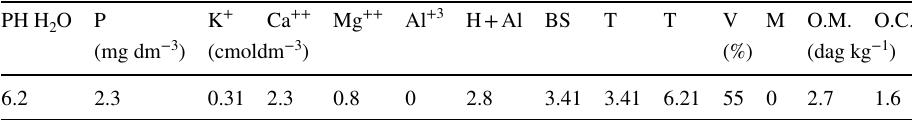
Table 2 Chemical properties of the sewage sludge biosolid and the sugarcane filter cake